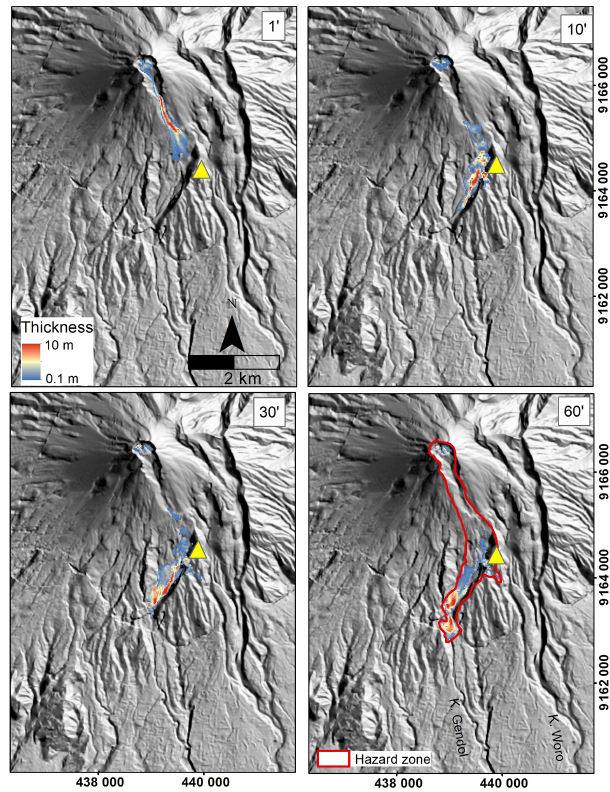
Figure 8. Result of the numerical simulation of the pyroclastic block-and-ash flow that may form due to the collapse of the delin- eated southern dome sector after 1, 10, 30 and 60min. The block- and-ash flow is deflected by the Kendil hills (yellow triangle) within ∼ 1min after the collapse. The red outline indicates the total inun- dation zone as a result of the deposition of the block-and-ash flow material. Coordinates are in UTM